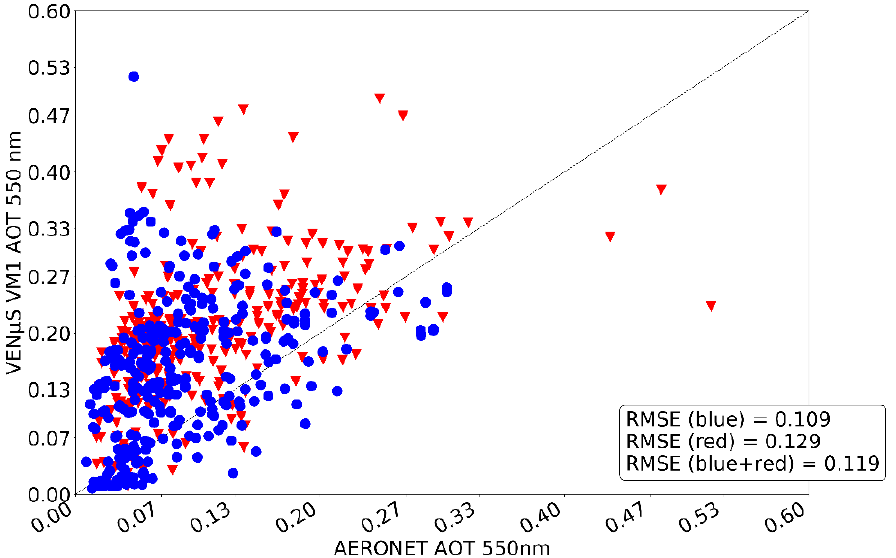
Figure 29. Quality assessment of Level-2 AOD estimation by comparison to concomitant AERONET measurements. In blue, concomitant VEN µ S and AERONET measurements with high confidence comparison criteria; in red, medium confidence comparison criteria.